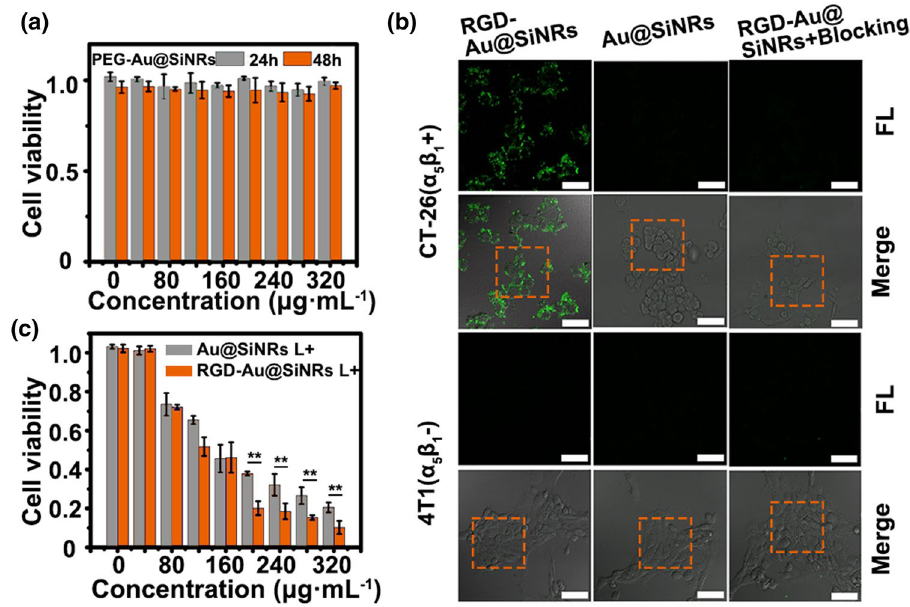
Fig. 3 Assessment of the biocompatibility, targeted imaging, and photothermal effect in vitro. a Cytotoxicity of PEG-Au@SiNRs. b LSCM images of CT-26 and 4T1 cells after incubation with RGD-Au@SiNRs (blocking with free peptides or not) or Au@SiNRs for 2 h at 37 °C. Scale bars, 25 μm. c Cell viability of CT-26 cells, which were first incubated with RGD-Au@SiNRs or Au@SiNRs for 4 h and then irradiated by an 808-nm laser (0.8 W cm −2 ) for 5 min as mean ± SD ( n = 3). Asterisk (**) indicates p <